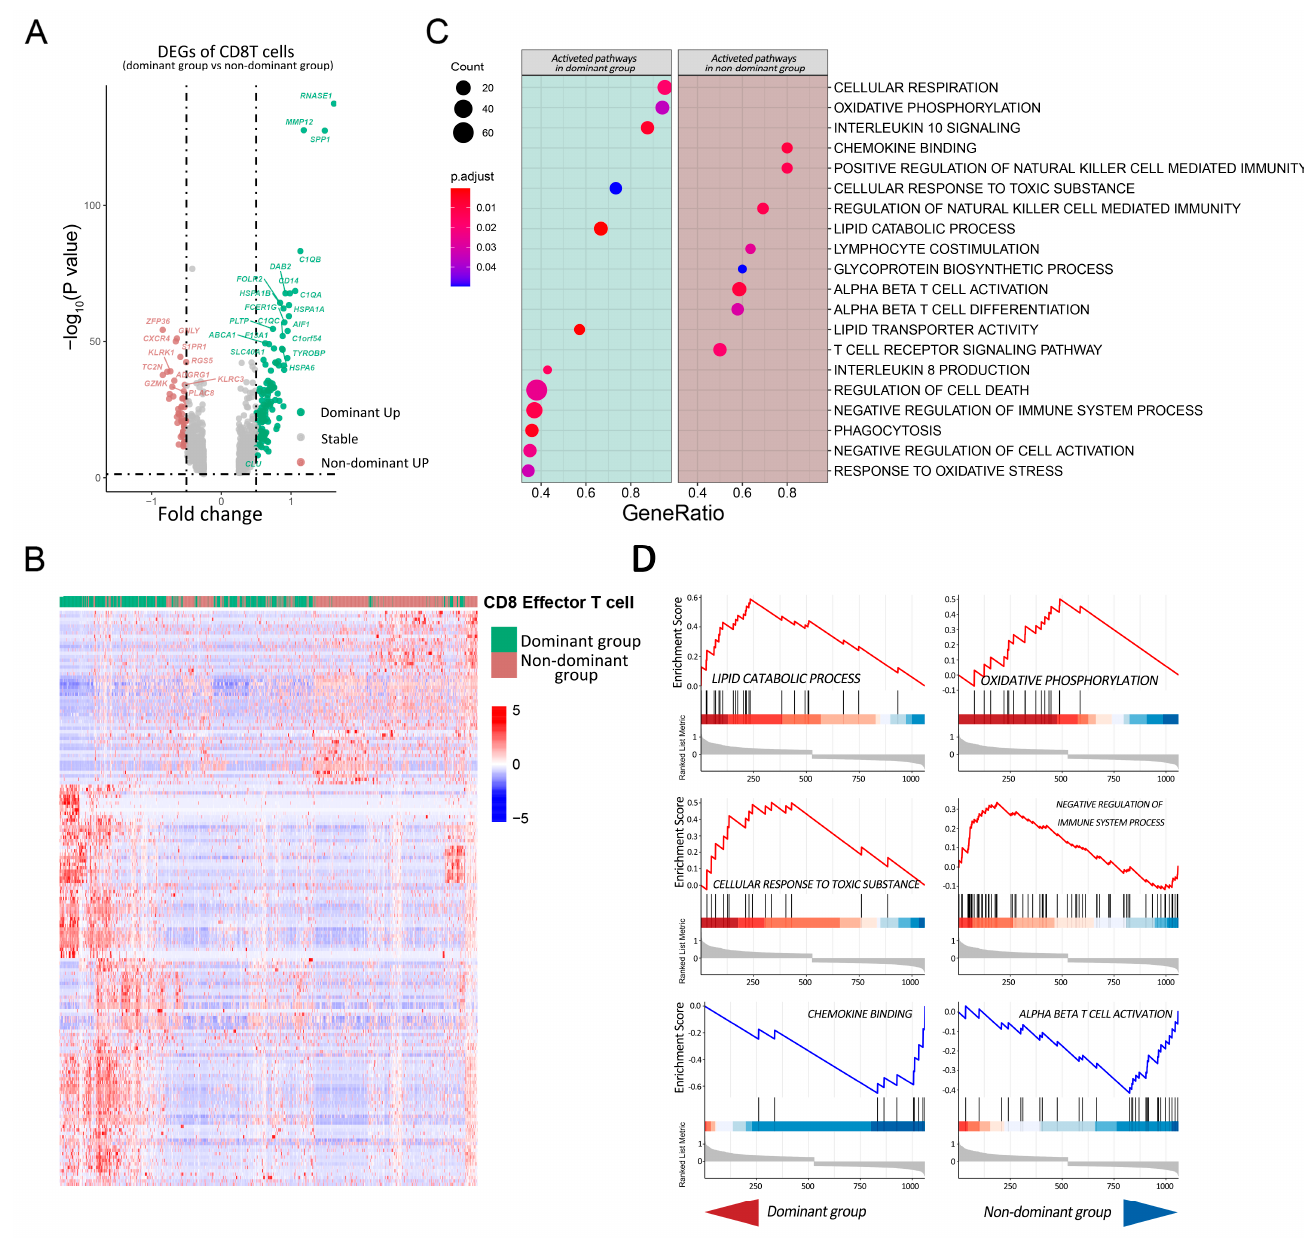
Figure 4. GSEA analysis of DEGs between CD8T cells in the dominant group and nondominant group. ( A ) Volcano plot of DEGs in CD8T cells of different populations. Green dots indicate genes upregulated in the dominant group and brown dots indicate genes upregulated in the nondominant group. The DEGs of CD8T cells in the TME of the dominant group and nondominant group are listed in Supplementary Table S6. ( B ) Heatmap of DEGs in CD8T cells of different populations. Rows indicate DEGs, columns are CD8T cells, and cell types are annotated above the heatmap. ( C ) Dot plot of gene set enrichment analysis (GSEA) showing enriched pathways of CD8T cells in the different groups. The size of each dot represents the enriched gene count in a pathway; the color of each dot indicates the significance test, with red showing greater significance. The results of the GO, REACTOME and HALLMARK for the dominant group and nondominant group are listed in Supplementary Table S7. ( D ) GSEA plots of 6 pathways are shown: 4 upper plots were activated in CD8T cells of the dominant group (enrichment score > 0), and 2 lower plots were activated in the nondominant group (enrichment score < 0).